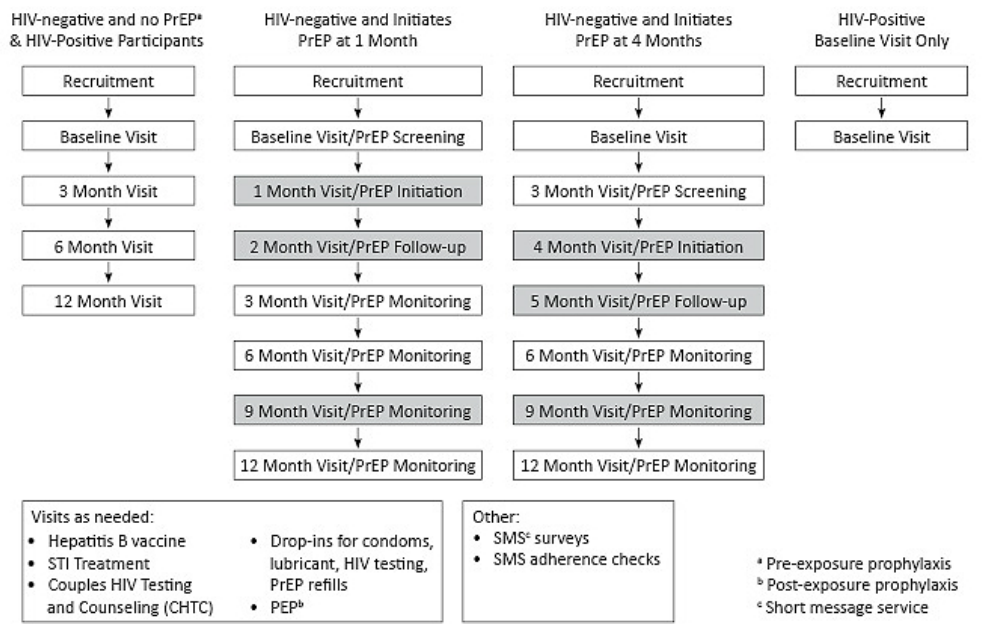
Figure 3. Visit schedules by participant